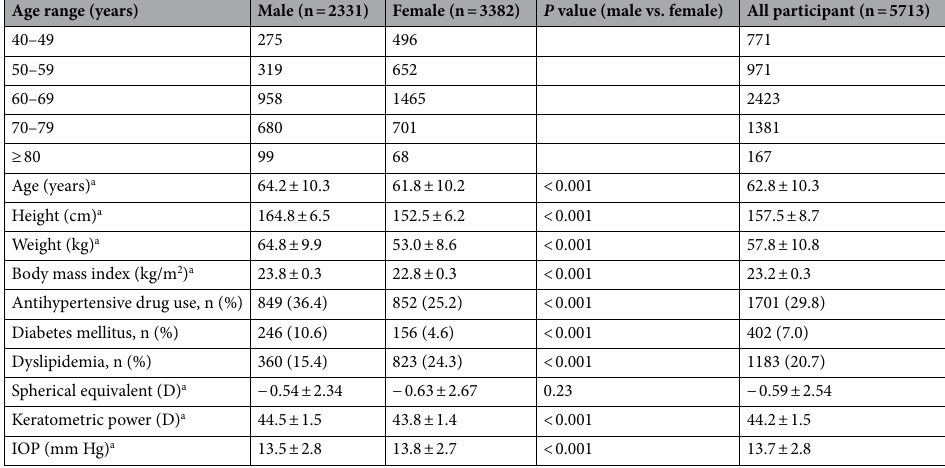
Table 1. Participant demographics. D diopter, IOP intraocular pressure, n number. a Mean ± standard